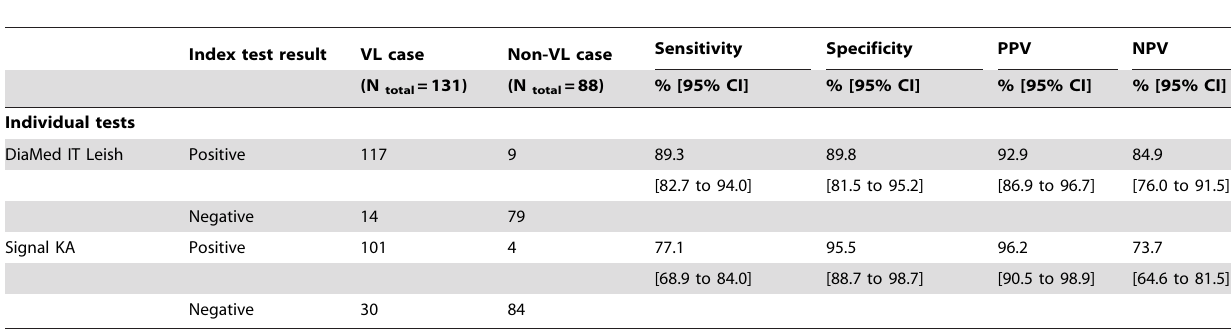
Table 2. Sensitivity, specificity, negative and positive predictive values of the DiaMed IT-LEISH and the Signal KA for VL diagnosis in Kacheliba and Kimalel, Rift Valley province,